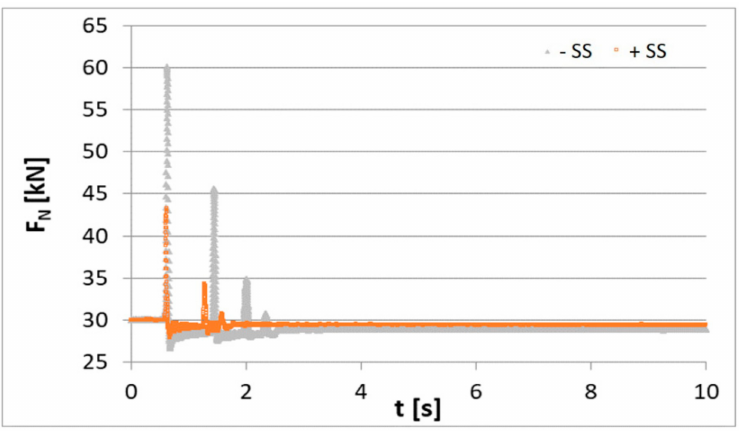
Figure 10. Influence of the support system on the time course of the tensile force F N